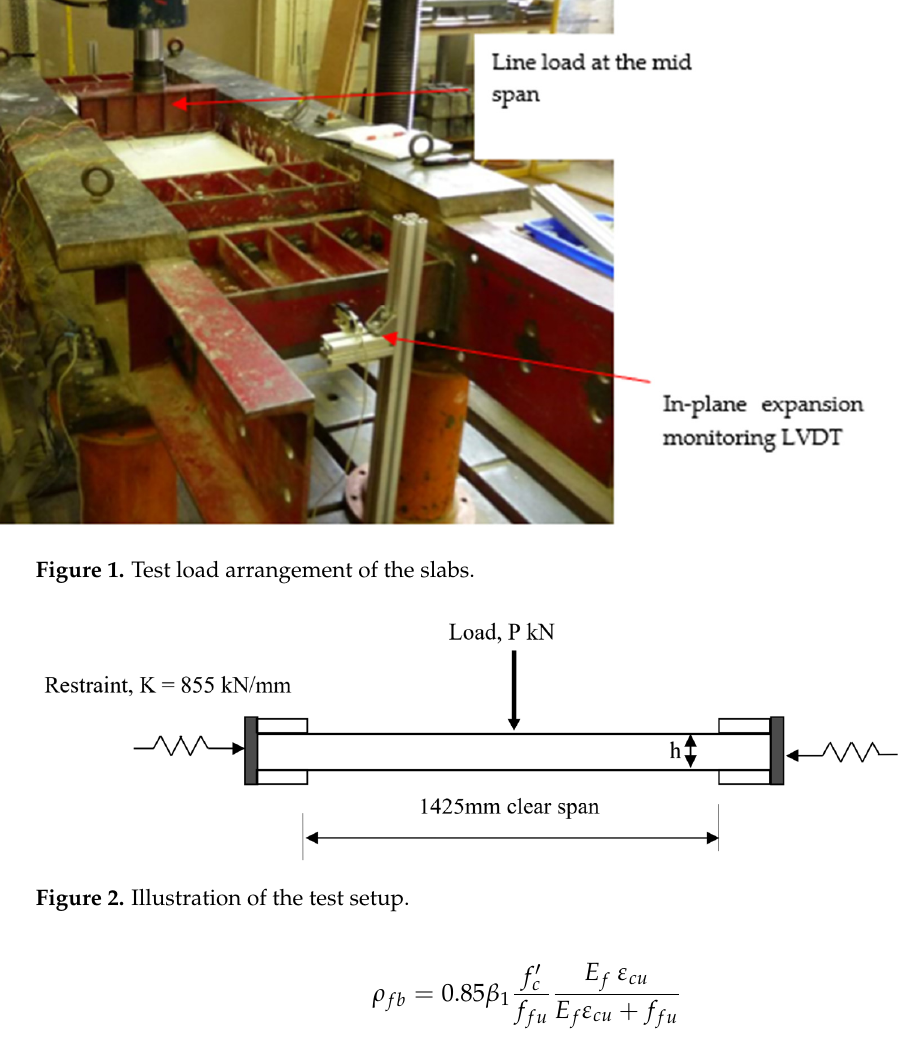
Figure 2. Illustration of the test setup.